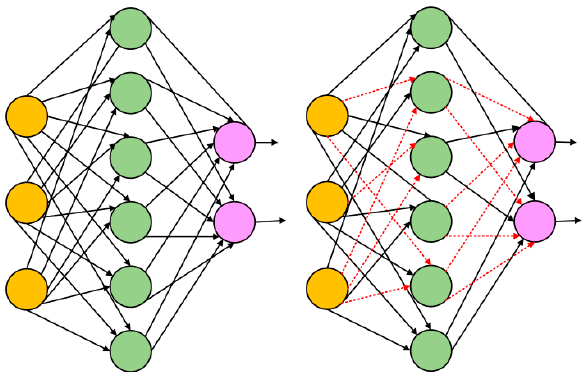
Figure 3. The dropout operation in the neural network. The dashed lines indicate randomly deleted neurons to prevent overfitting.